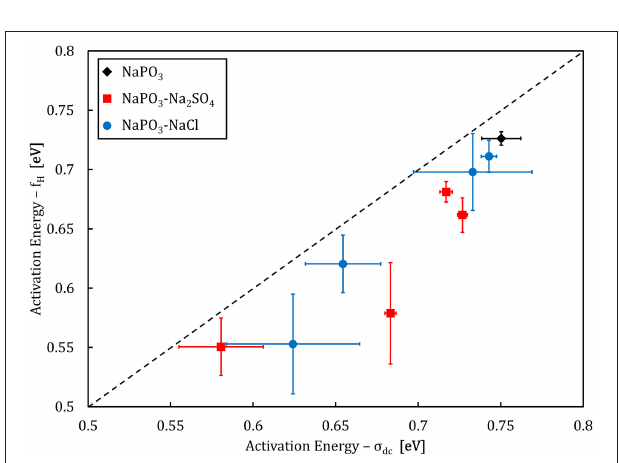
FIGURE 9 | Activation energy of the onset frequency f H compared to the activation energy of dc conductivity σ dc . The dashed line illustrates a 1:1 ratio.